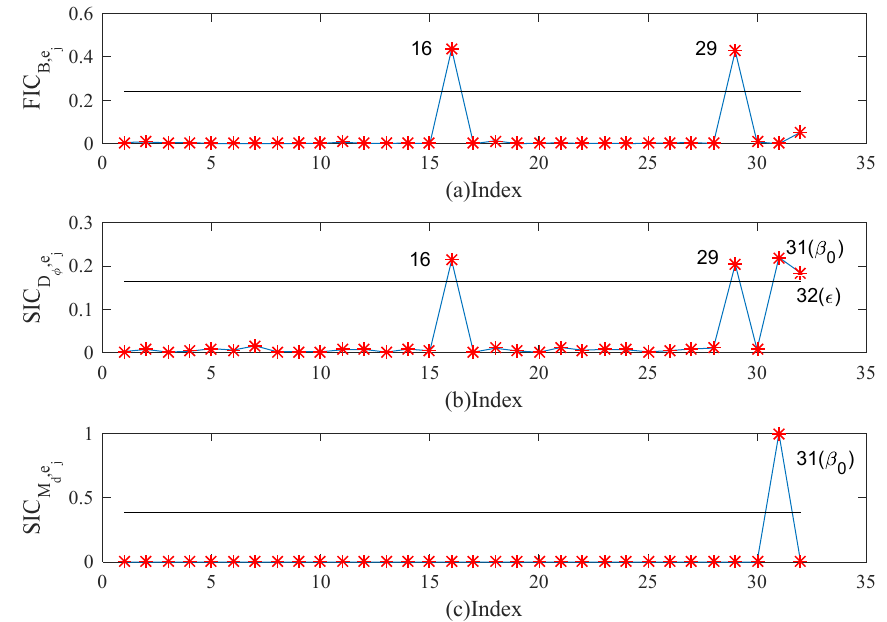
Figure 3. Plots of simultaneous perturbation in Simulation 2.